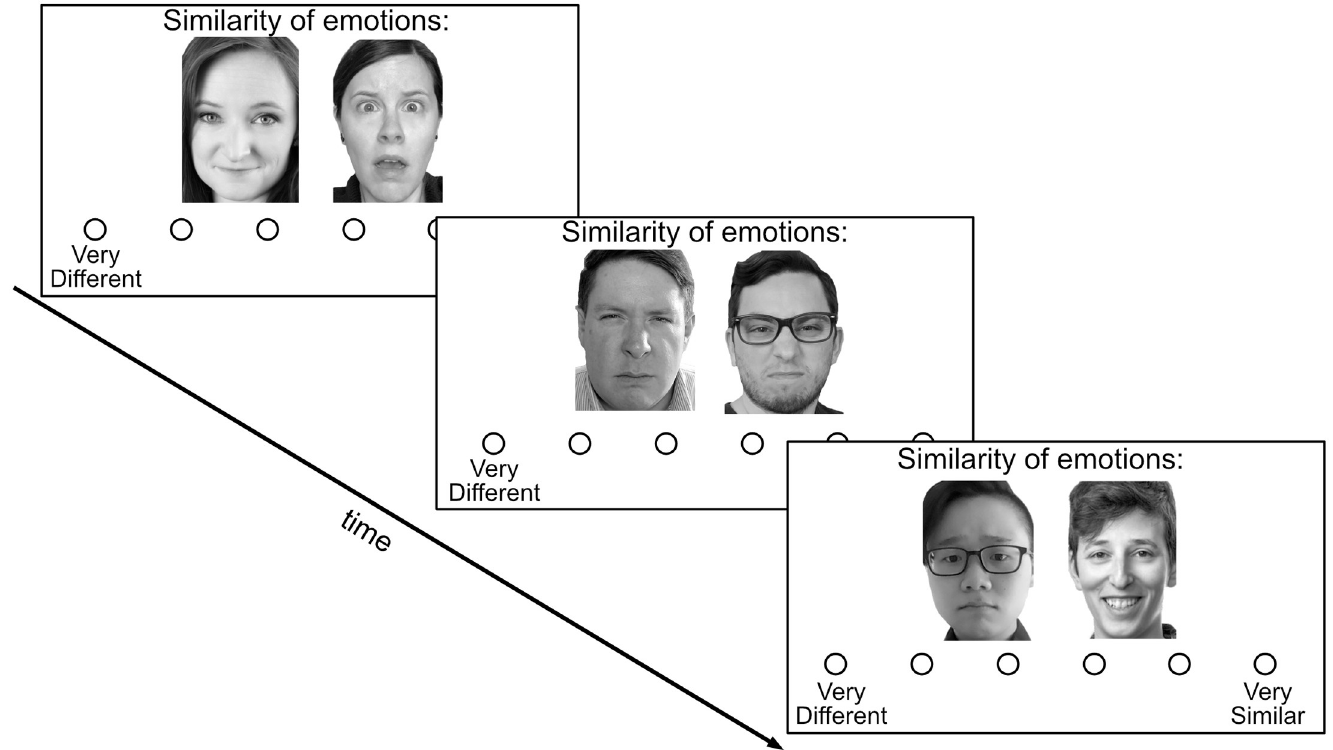
Fig 1. Example trials for face similarity task. Each trial presents a pair of emotional faces. Participants rate the similarity of the expressed emotions. The images pictured here are similar, but not identical, to the original images used in the study, and are for illustrative purposes only.